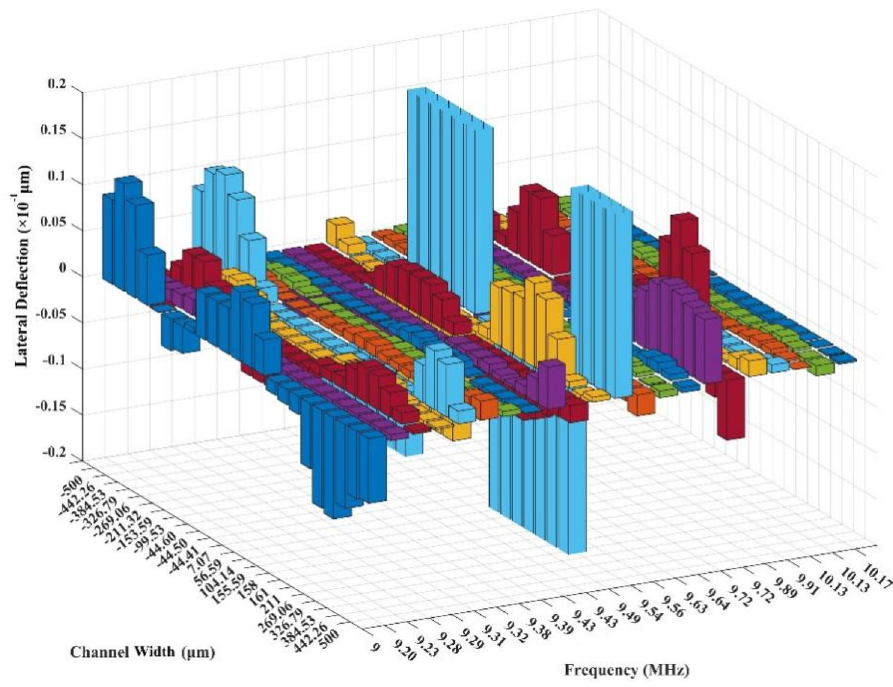
Figure 2. Harmonic analysis results for the substrate polarization amplitude along the z-axis in the derived frequencies from modal